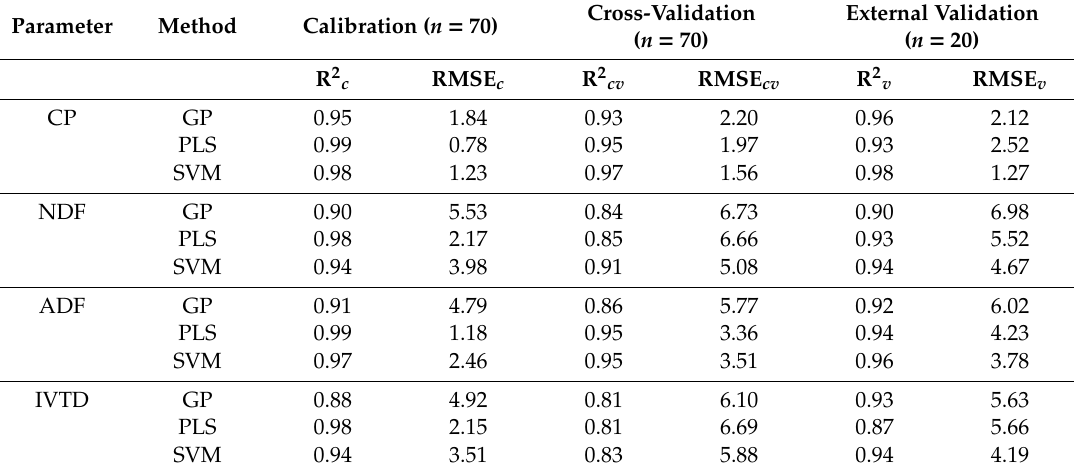
Table 2. Calibration, cross-validation, and external validation statistics obtained for crude protein (CP), neutral detergent fiber (NDF), acid detergent fiber (ADF), and in vitro true digestibility (IVTD) in guar using three calibration